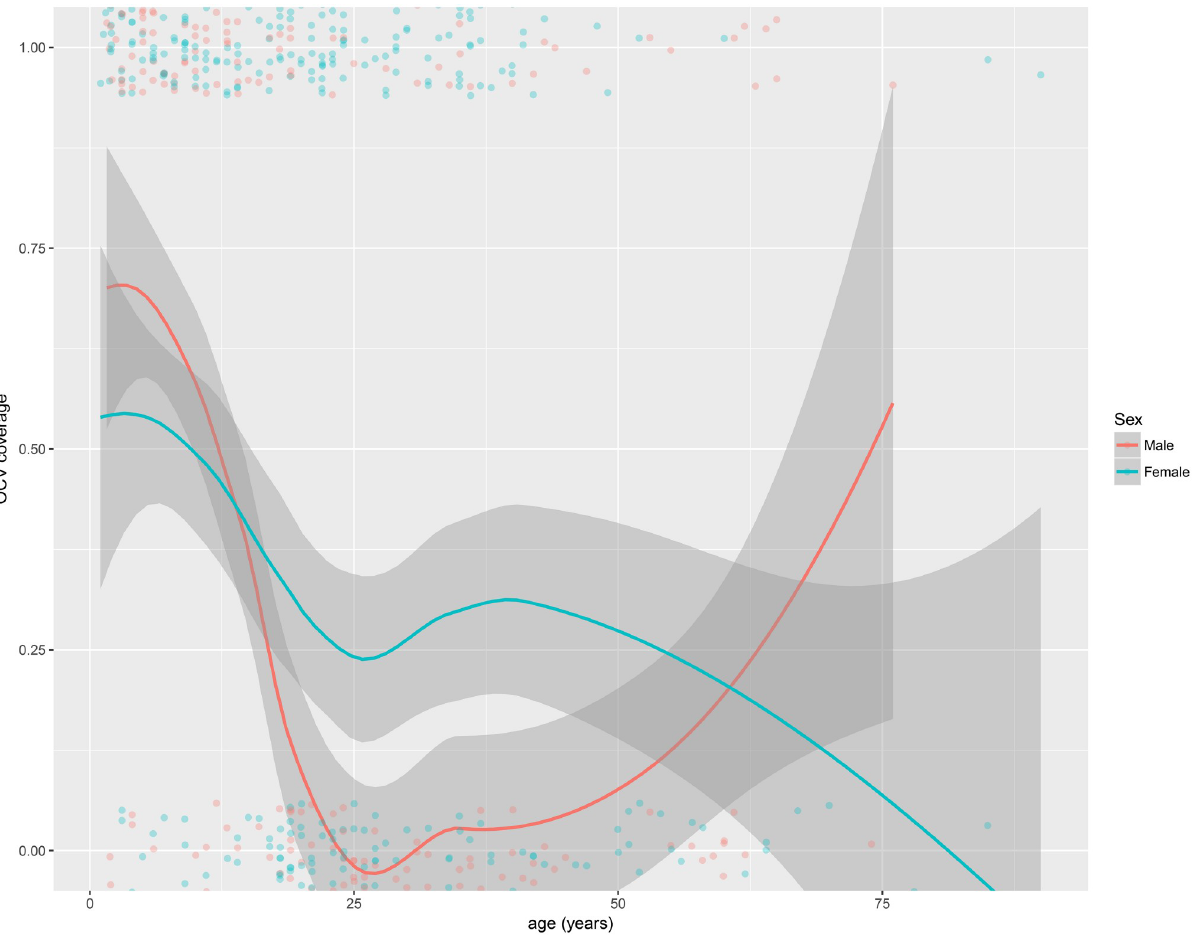
Fig 4. Vaccination coverage with two OCV doses by age and sex, Zambia,